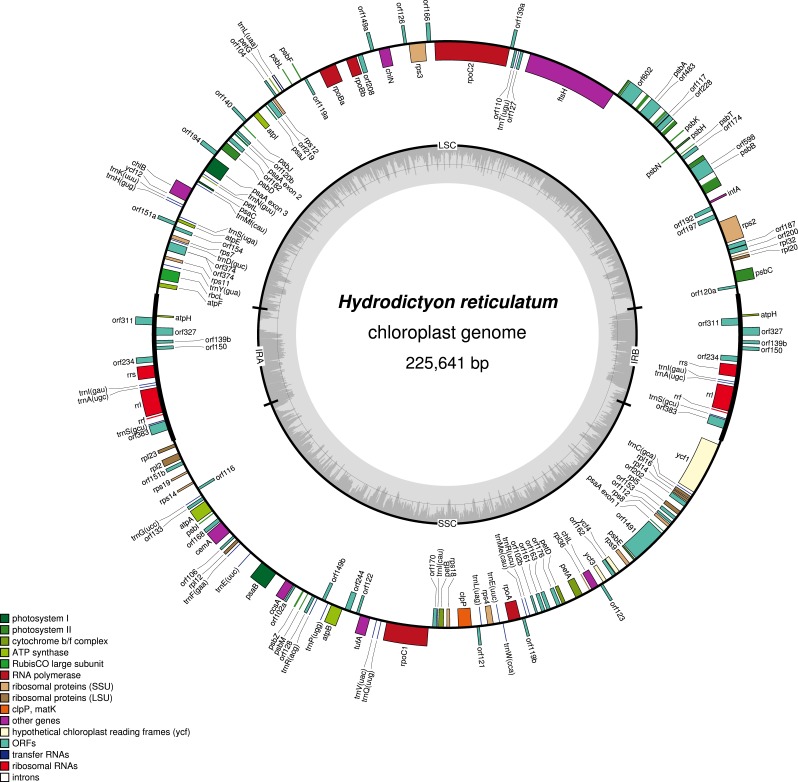
Gene map of Hydrodictyon reticulatum plastome (KY114065).The inverted repeats (IRA and IRB) which separate the genome into two single copy regions are indicated on the inner circle along with the nucleotide content (G/C dark grey, A/T light grey). Genes shown on the outside of the outer circle are transcribed clockwise and those on the inside counter clockwise. Gene boxes are color coded by functional group as shown in the key.